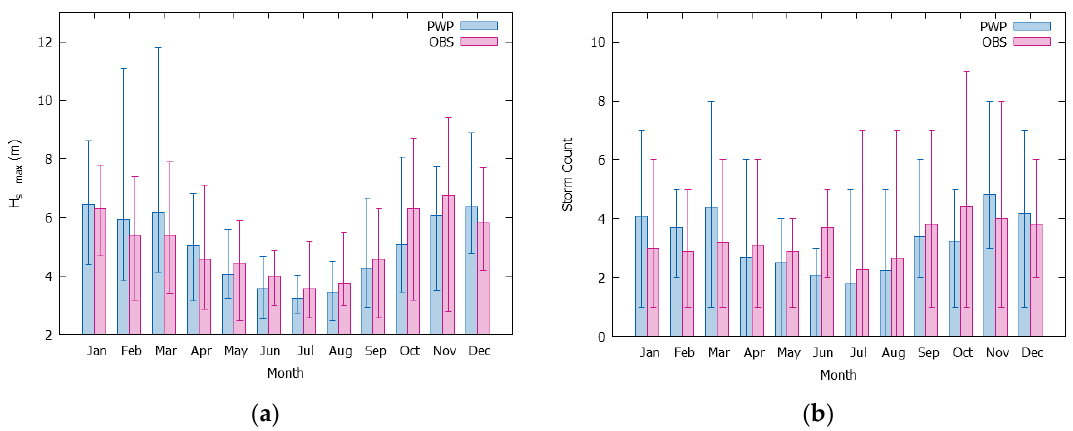
Figure 6 . Comparison of the observed and modelled “present” annual averaged monthly 𝐻 𝑠 max and storm count for Pembroke. ( a ) 𝐻 𝑠 PWP compared to the observed; ( b ) storm count PWP compared to the observed.